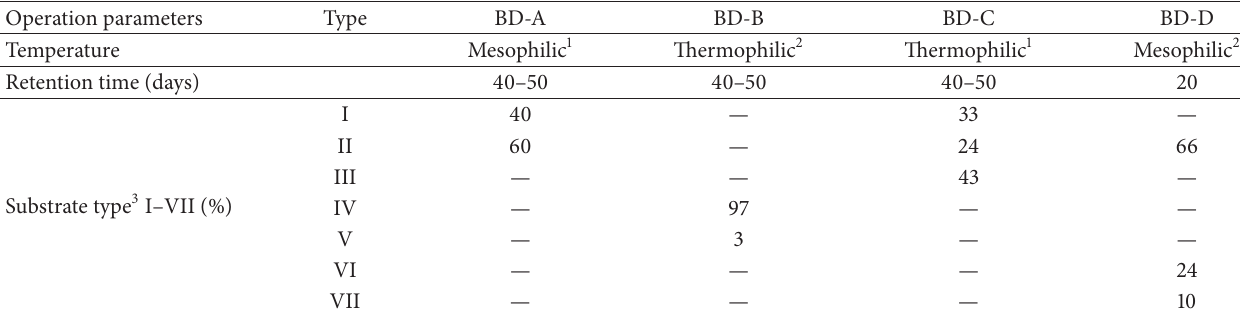
Table 2: Operating parameters of the biogas plant reactors (i.e., temperature, retention time, and substrate) from which the four biogas digestates (BD-A, BD-B, BD-C, and BD-D) were obtained. Operation parameters